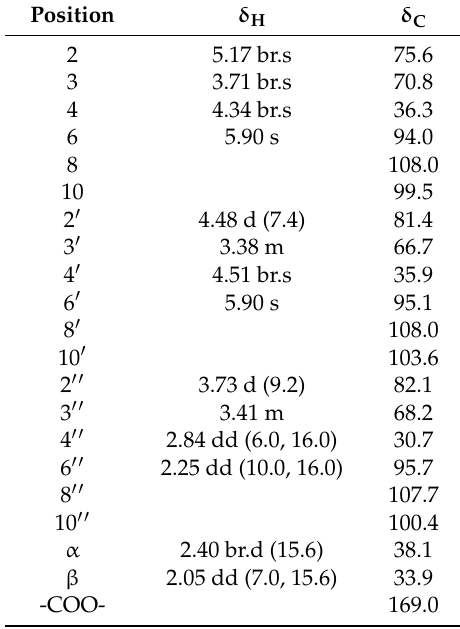
Table 1. 1 H- (400 MHz) and 13 C-NMR (100 MHz) data of 1 (in DMSO- d 6 , J in Hz, δ in